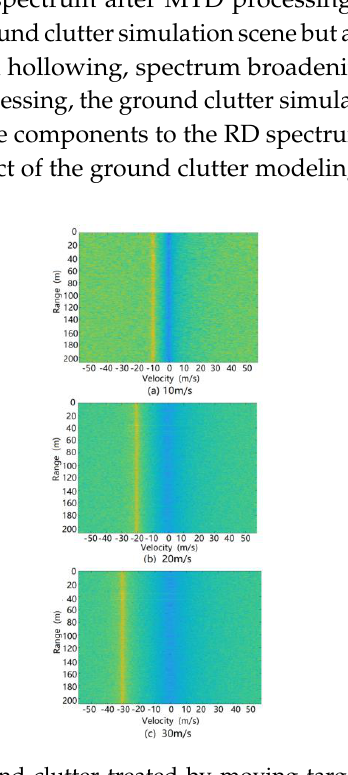
Figure 16. RD spectrum of simulated ground clutter at different speeds of radar-carrying vehicles.